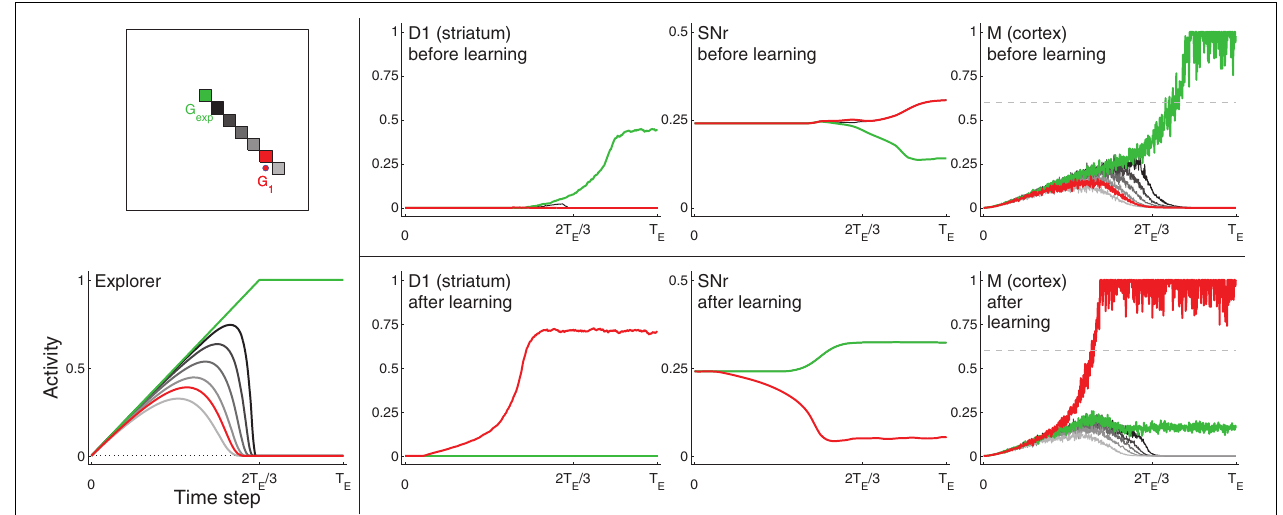
example. Note, however, that, unlike with Figure 3 , the reinforced movement is one unit away from the center of G 1 (the center of G 1 is marked with a closed red circle). (Recall that the radius of the target is 1 . 1 units, so movements made to the center of G 1 or to the immediate neighbors of the center are reinforced.) The green neuron corresponds to the location of G exp (focus of excitation in Explorer), which is not within the target area.